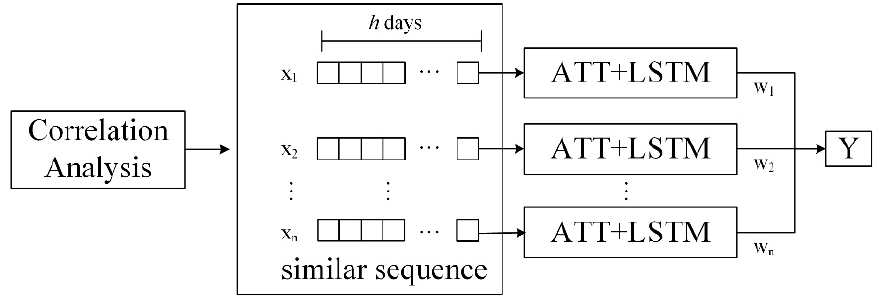
Figure 4. The ATT-LSTM prediction model that considers the synergy of similar time series.